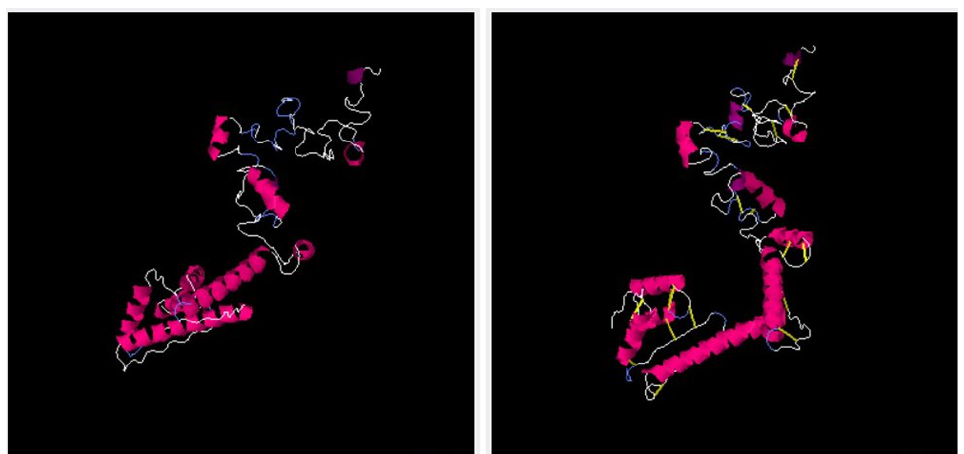
Figure 5. Three-dimensional structure of designed vaccine.